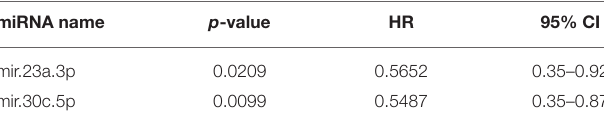
TABLE 4 | Two miRNA models after step-wise Cox proportional hazard regression ( R 2 = 0.278, concordance =